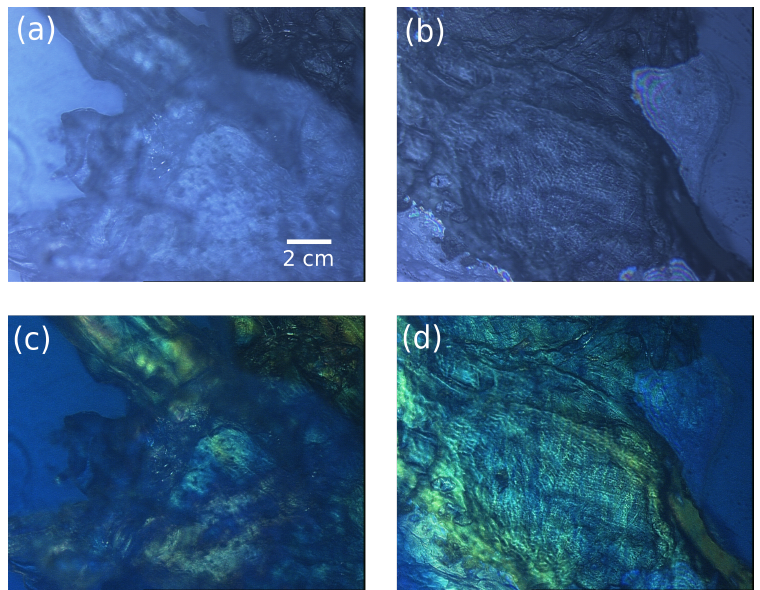
Figure 5. 736 × 574 pixel images of a rabbit leg. Images show ( a , c ) the connective/muscular tissues and ( b , d ) the tendon region ( b , d ). The images are obtained under total light intensity ( a , b ) and polarized light ( c , d ) from a Leica